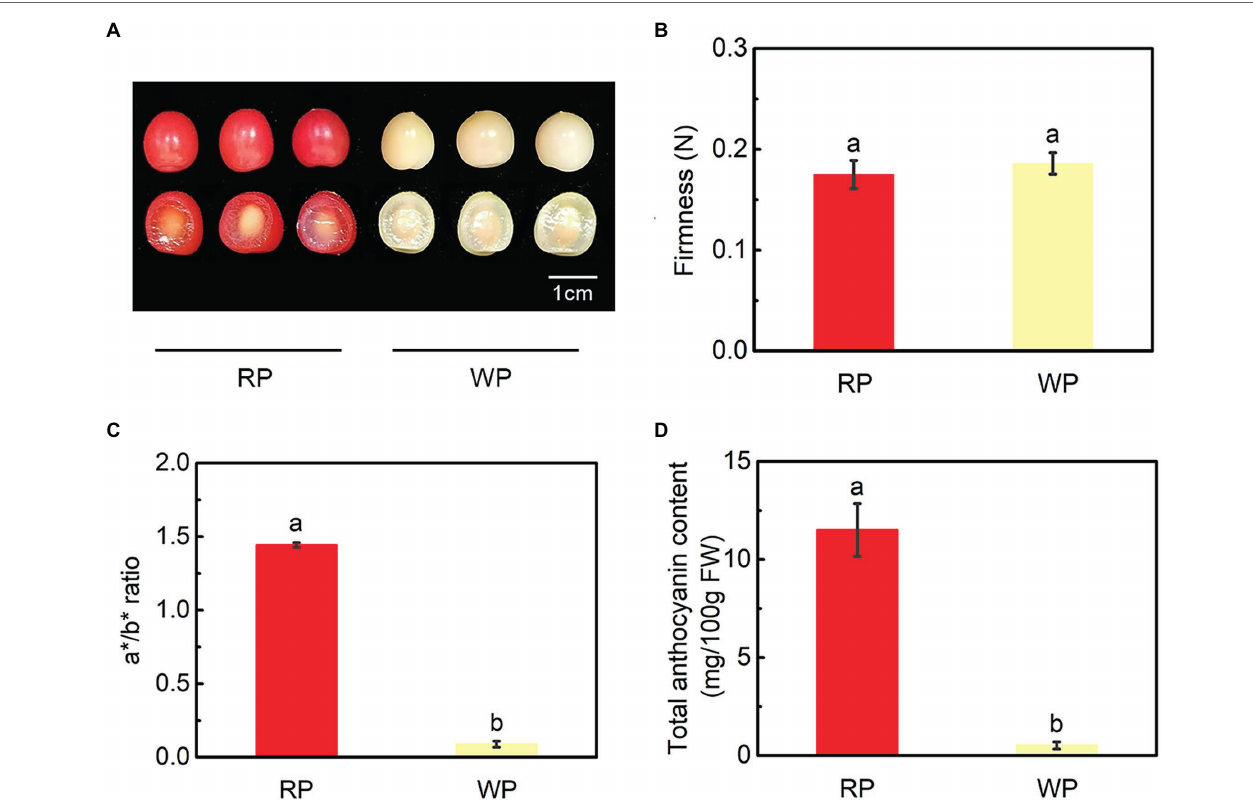
FIGURE 1 | Phenotypes and physiological changes of red and white fruit of Prunus tomentosa in mature stage. (A) Phenotypes of red and white P. tomentosa ; (B) Fruit firmness (N); (C) Changes in a*/b* ratio; (D) Total anthocyanin content of cherry fruit. RP, red-color cultivar of P. tomentosa ; WP, white-color cultivar of P. tomentosa . Error bars in (B–D) represent ± SE from three replicates. Tukey’s test significant at p < 0.05 is indicated by a and